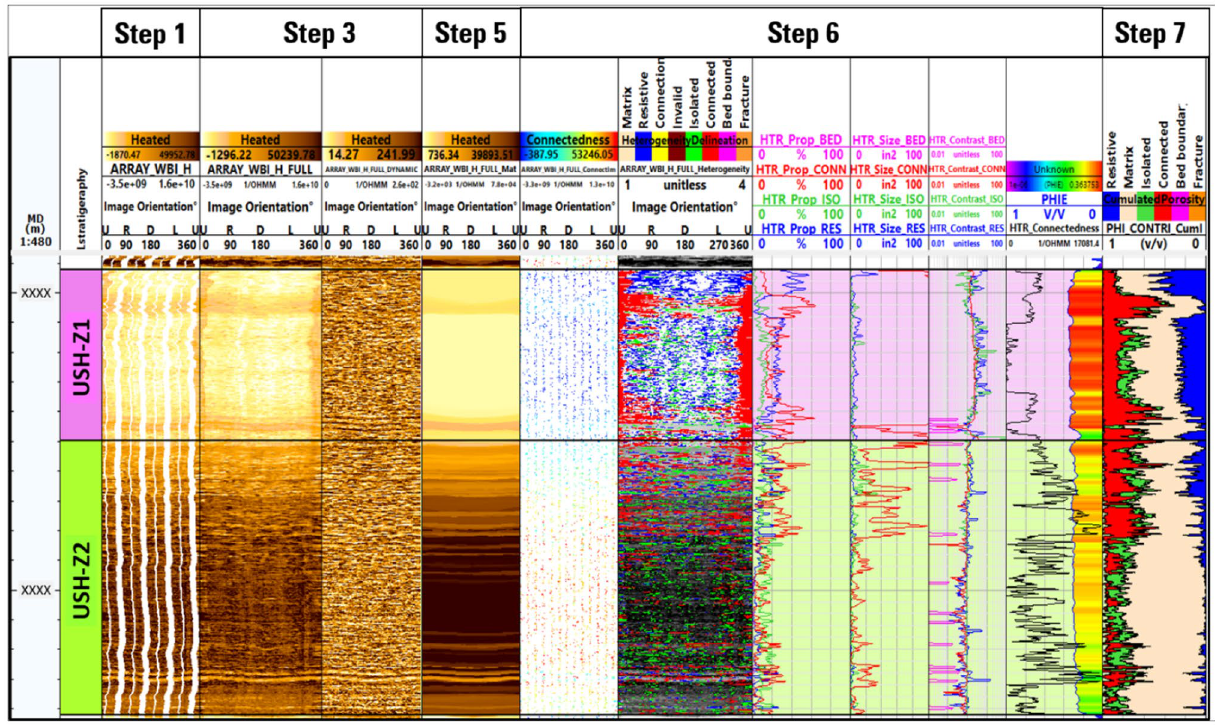
Fig. 16 Heterogeneity analysis with their steps and results for well #4. Track 3: Static Image log, Track 4: Gap filling the image, Track 5: Mosaic index image, Track 6: Matrix image log, Track 7: Connect-